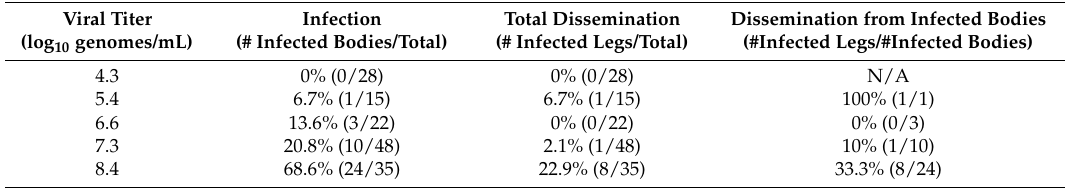
Table 2. Mosquito infectivity of cynomolgus macaque bloodmeal after 14 days extrinsic incubation. Viral Titer (log 10